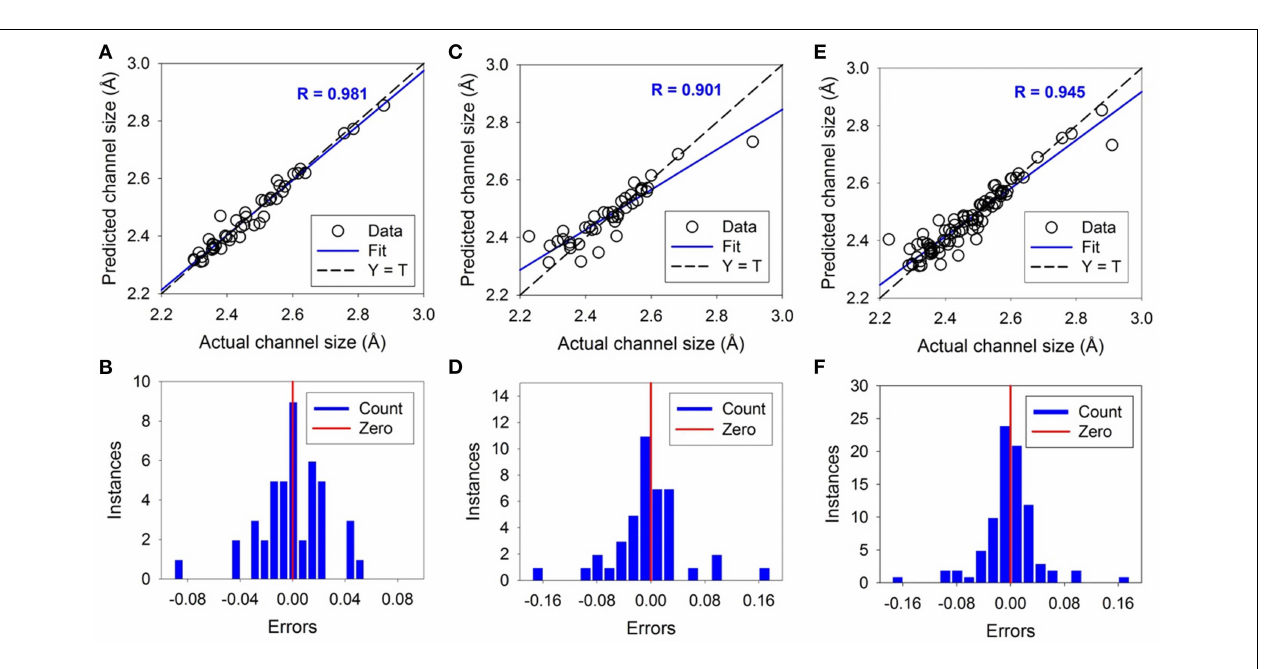
FIGURE 7 | The results of Artificial Neural Network simulations of the channel size. The upper figures show the correlations between predicted and actual values. The bottom figures show the error distributions around the vertical red bars of zero error. The dashed lines